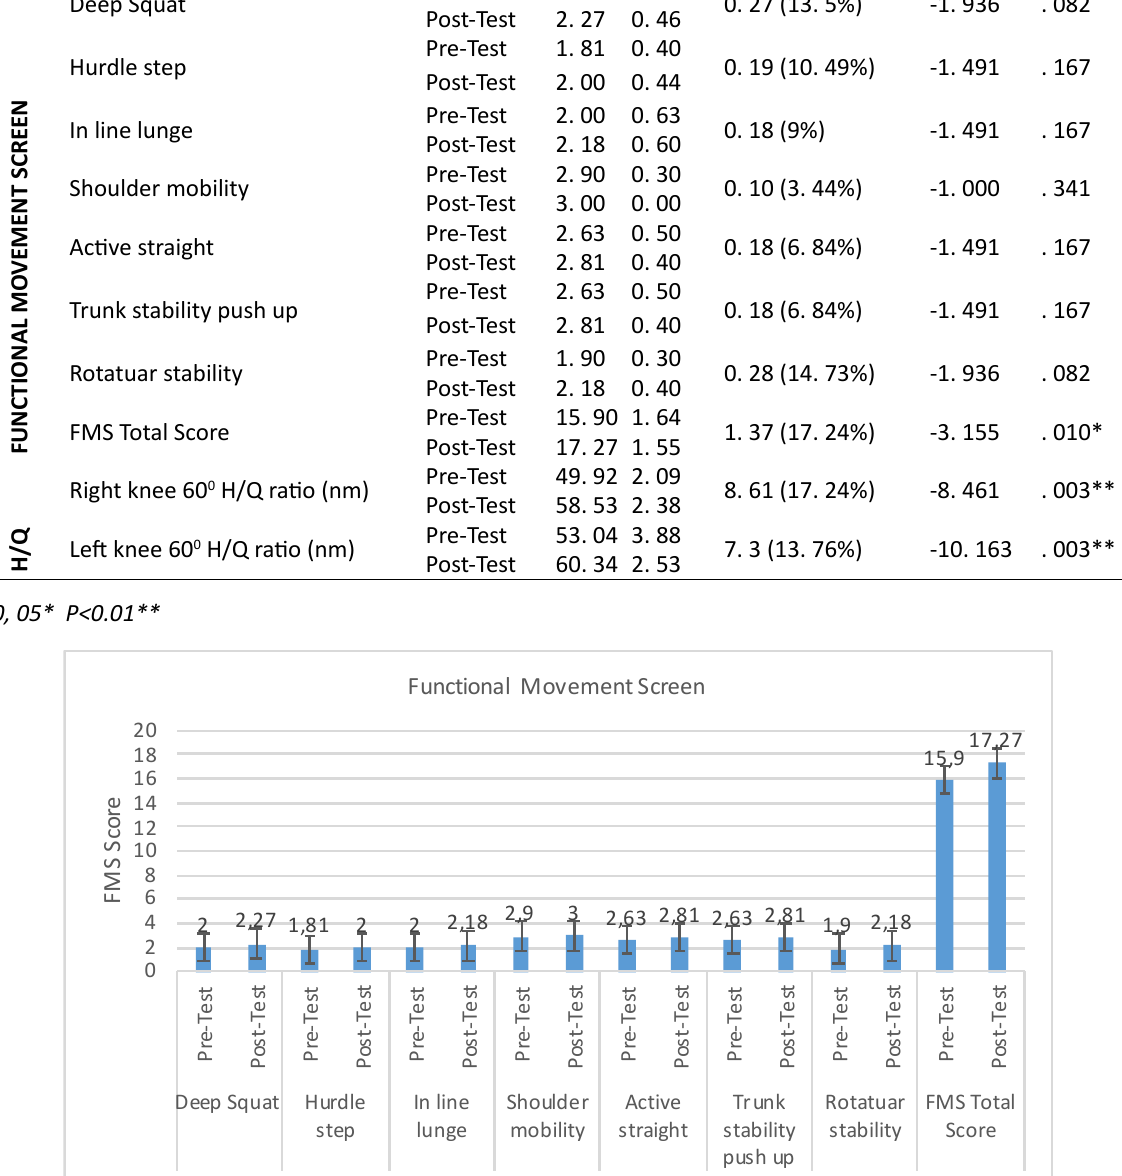
Table 3. Comparison of pre-test and post-test measurements related to FMS and H/Q ratio of football group Variables